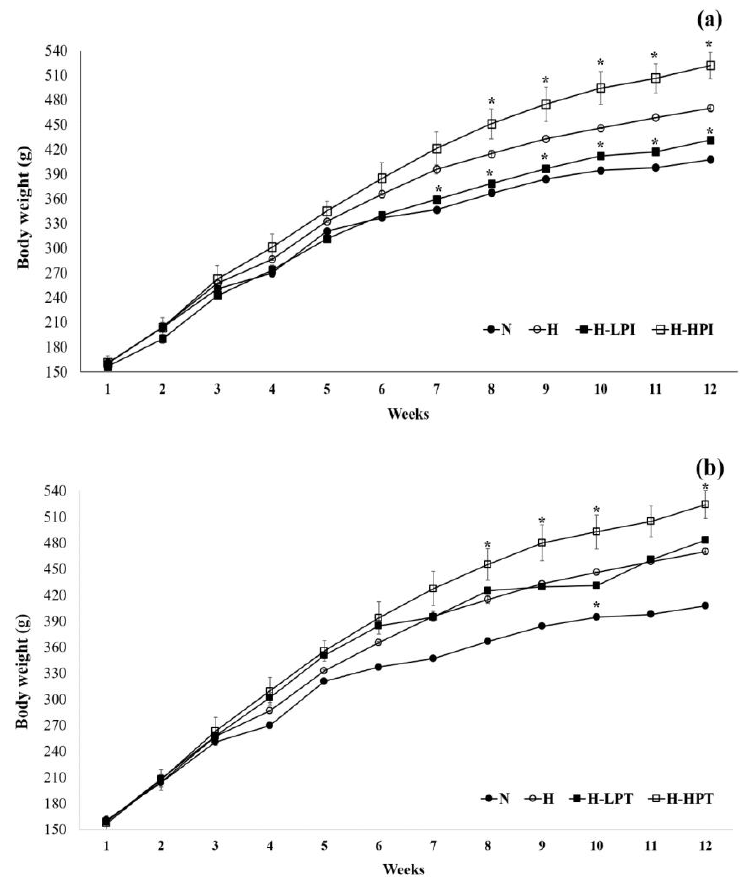
Figure 1. Changes in body weight between groups. ( a ) Animal groups fed high fat diet with inhalation of patchouli essential oil (PEO) during the induced period (7~12th weeks), and ( b ) animal groups fed high fat diet with inhalation of PEO during the total periods (1~12th weeks). Symbol (*) corresponds, at each time point, the significant difference among groups H versus inhalation of PEO by the non-parametric Friedman test followed by Dunn’s test ( p < 0.05).